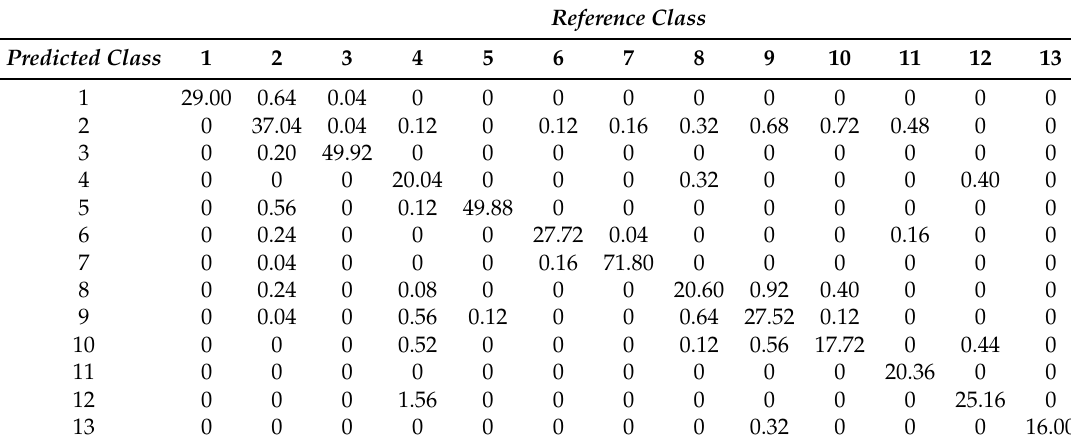
Table A1. Confusion matrix between the 13 tree species (level 3) computed in pixels and averaged over 25 repetitions (explaining why there are decimal fractions). The matrix is based on the best classification obtained using the smoothed W bands dataset and the SVM classifier. Rows and columns represent pixels in the classification and the reference respectively. The class labels are: 1 (Silver birch), 2 (Oak), 3 (Red oak), 4 (Douglas fir), 5 (Eucalyptus), 6 (European Ash), 7 (Aspen), 8 (Corsican pine), 9 (Maritime pine), 10 (Black pine), 11 (Black locust), 12 (Silver fir), 13 (Willow).